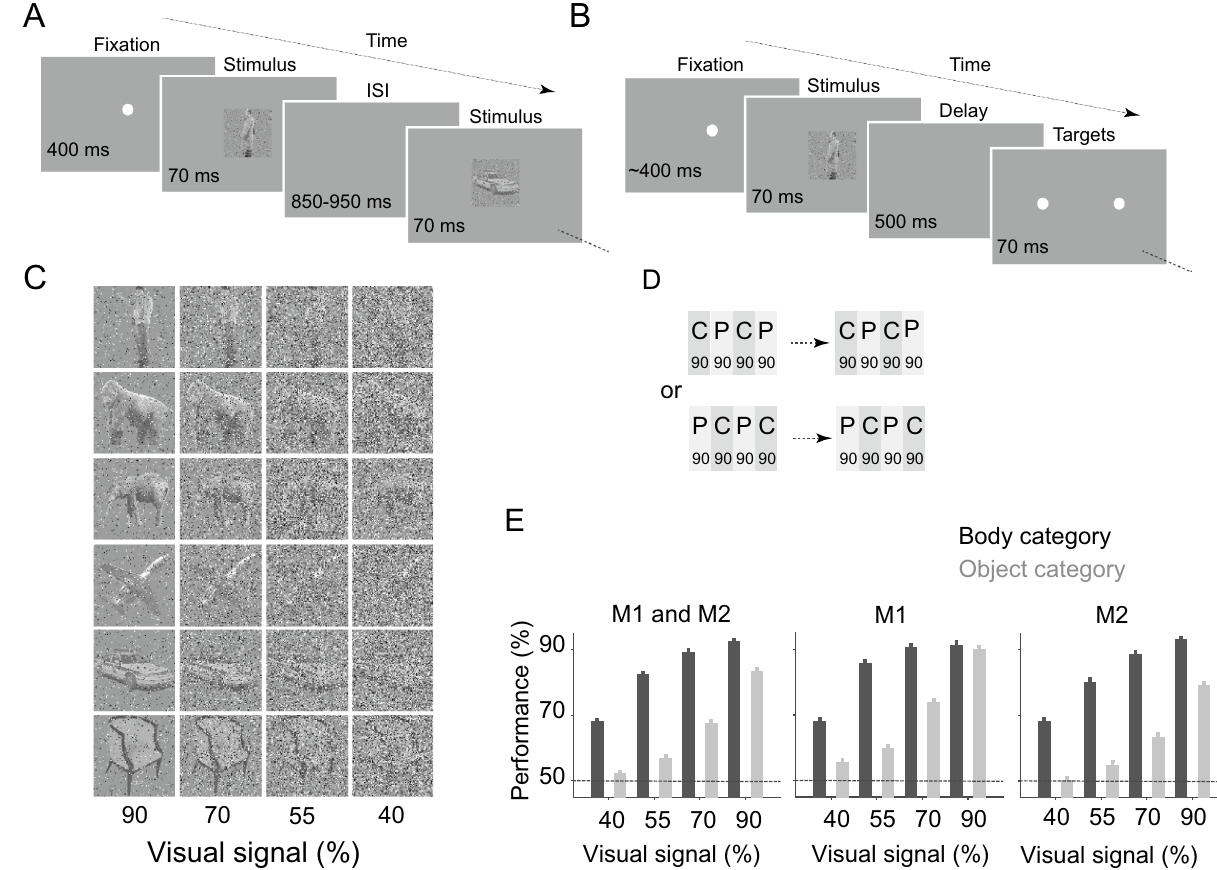
Figure 1. Task and performance. ( A ) Passive fixation task (ISI: inter-stimulus interval). ( B ) Body/object categorization task. ( C ) Exemplar body and object images in different noise levels. Numbers below the images show the percent of the added noise in each column of images. ( D ) Order of the tasks in a session. Each bar represents one block of 90 trials of categorization (C, dark gray) or passive (P, light gray) tasks. ( E ) Monkeys’ performance in the categorization task was plotted for both (M1 and M2 subplot) and each monkey (M1 subplot and M2 subplot). The dashed line indicates 50% chance level. Error bars indicate the